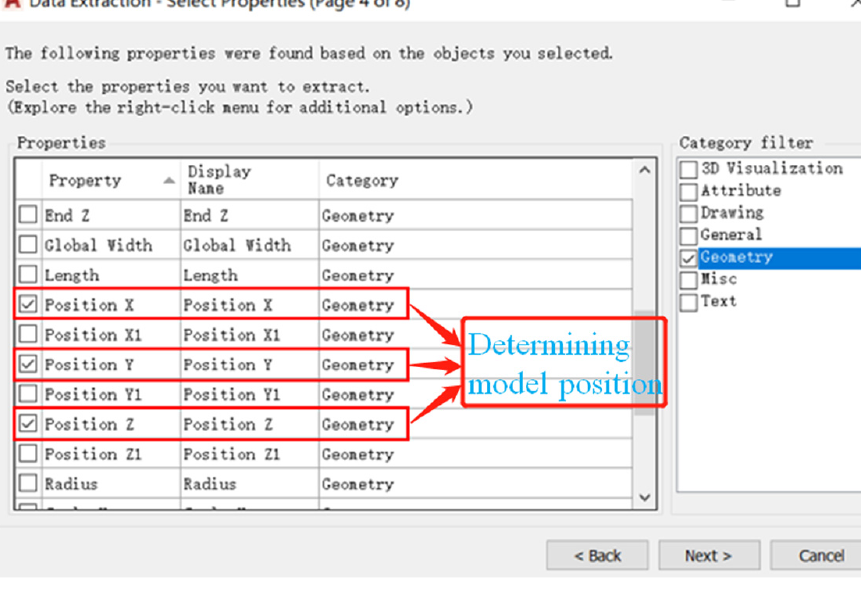
Figure 4. Diagram of data extraction.